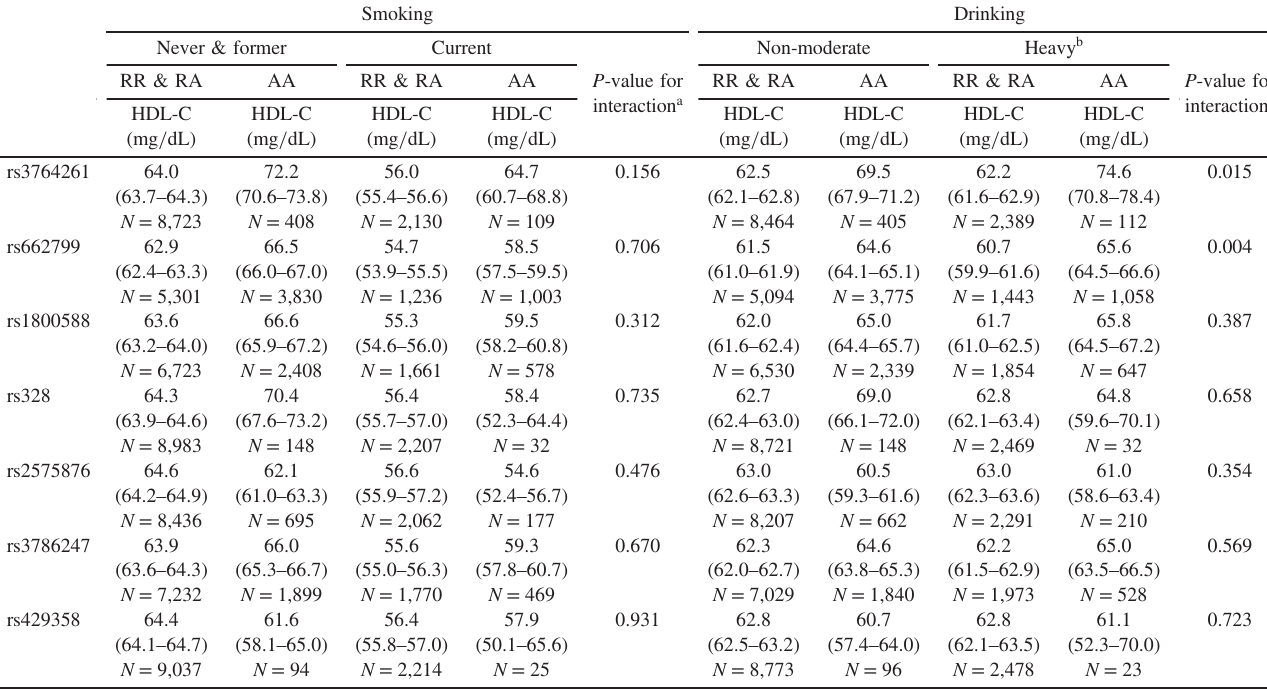
Table 4. Interaction between HDL-C levels according to di ff erent smoking and drinking statues and the 7 selected SNPs